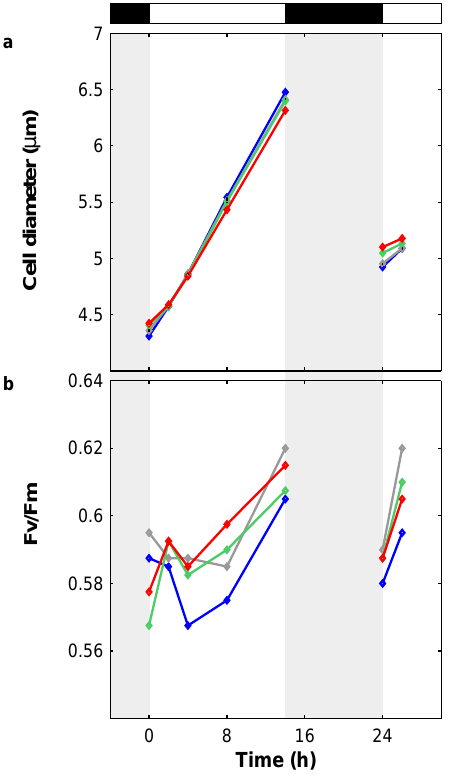
Fig. 5. (a) Cell diameter and (b) F v / F m of Emiliania huxleyi through time. In Fig. 5a each CO 2 level has 4 measurements from each bottle with vertical error bars representing standard errors. In Fig. 5b each data point results from the average of measurements done at 470, 520, 645 and 665nm in one bottle. 190µatmCO 2 (blue), 410µatmCO 2 (grey), 800µatmCO 2 (green), 1500µatmCO 2 (red). The white/black bar on top represents the light/dark diel cycle, vertical grey bars denote the dark